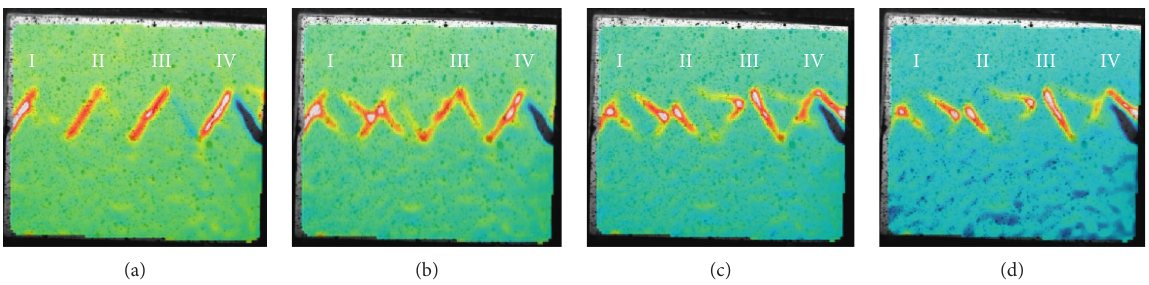
Figure 15: Typical development process of shear failure of jointed specimens (B-20).